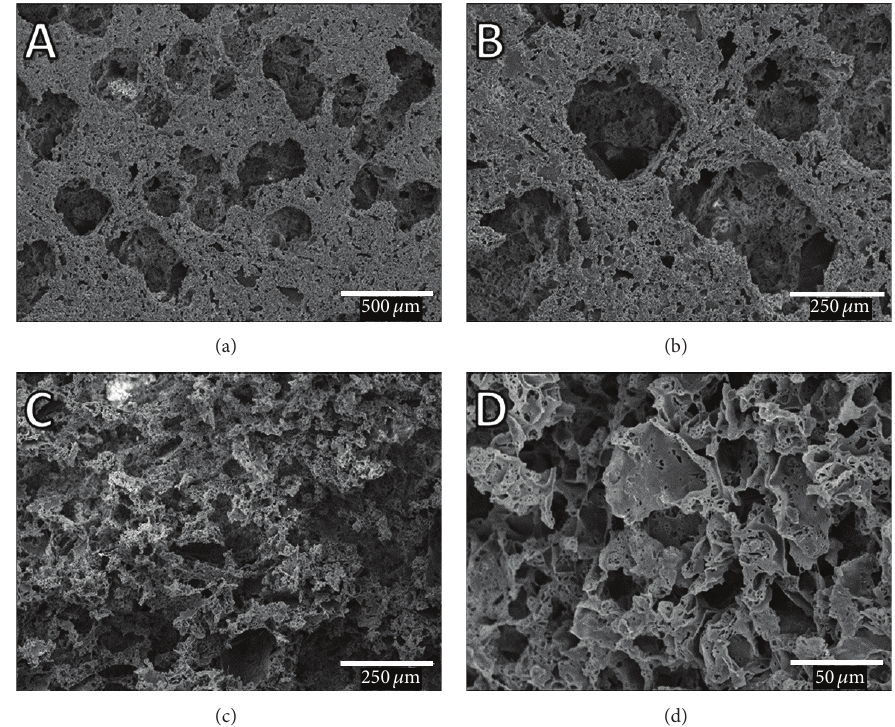
Figure 4: SEM of PLDLA-TMC scaffolds showing the external (a, b) and inner (c, d) surfaces. Inner views of the scaffolds were obtained after cryofracture.